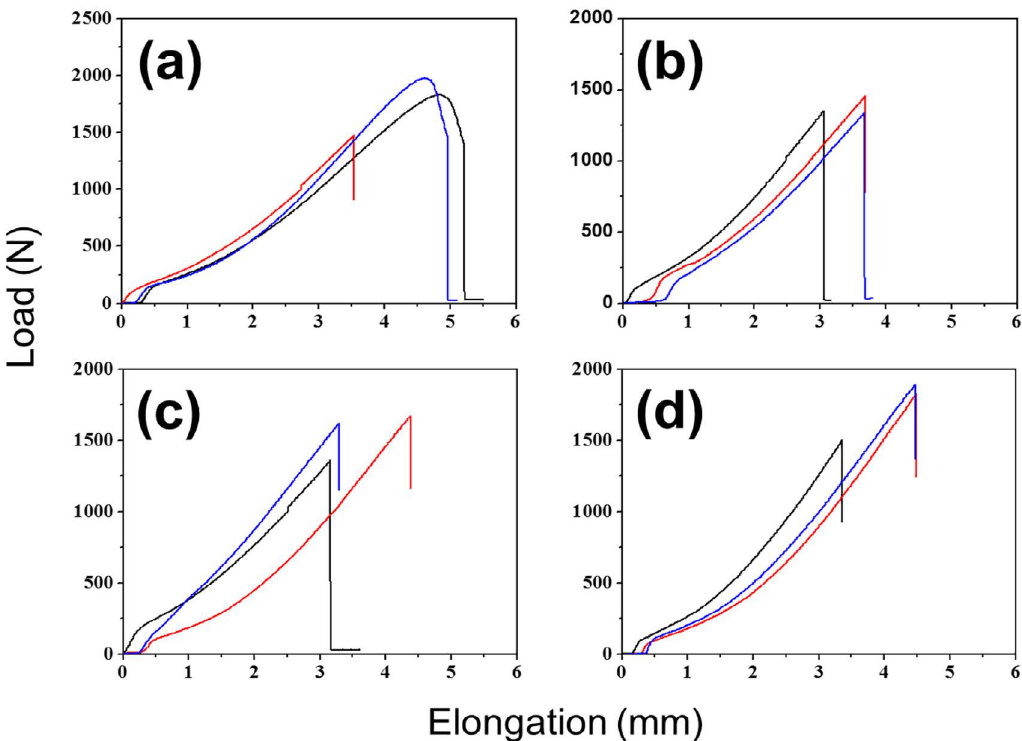
Figure 5. Tensile load versus elongation curves for: (a) plain epoxy; (b) 10 vol% guaruman fiber; (c) 20 vol% guaruman fiber; and (d) 30 vol% guaruman fiber reinforced epoxy